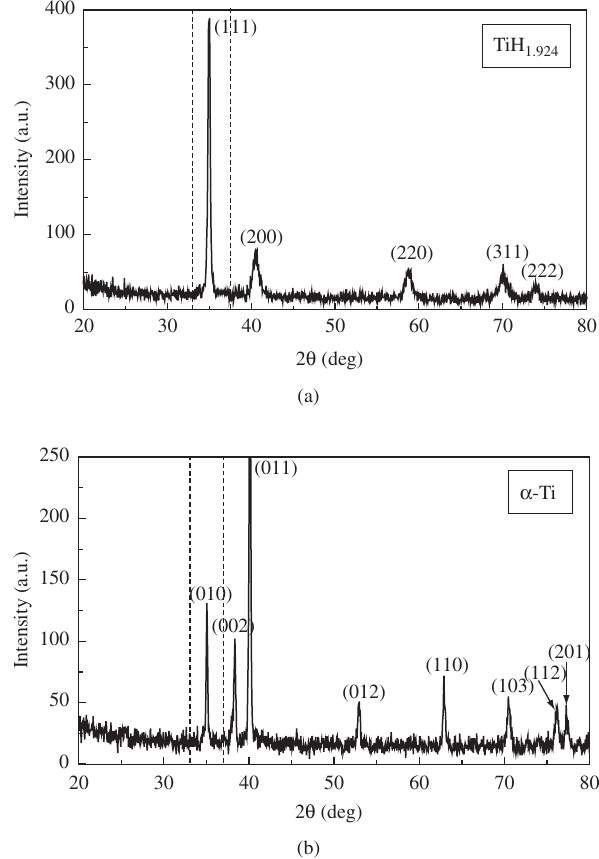
Figure 2. X-ray diffractograms corresponding to: a) the TiH b) α -phase after dehydriding process. The window for HTXRD measurements is marked with dashed lines.